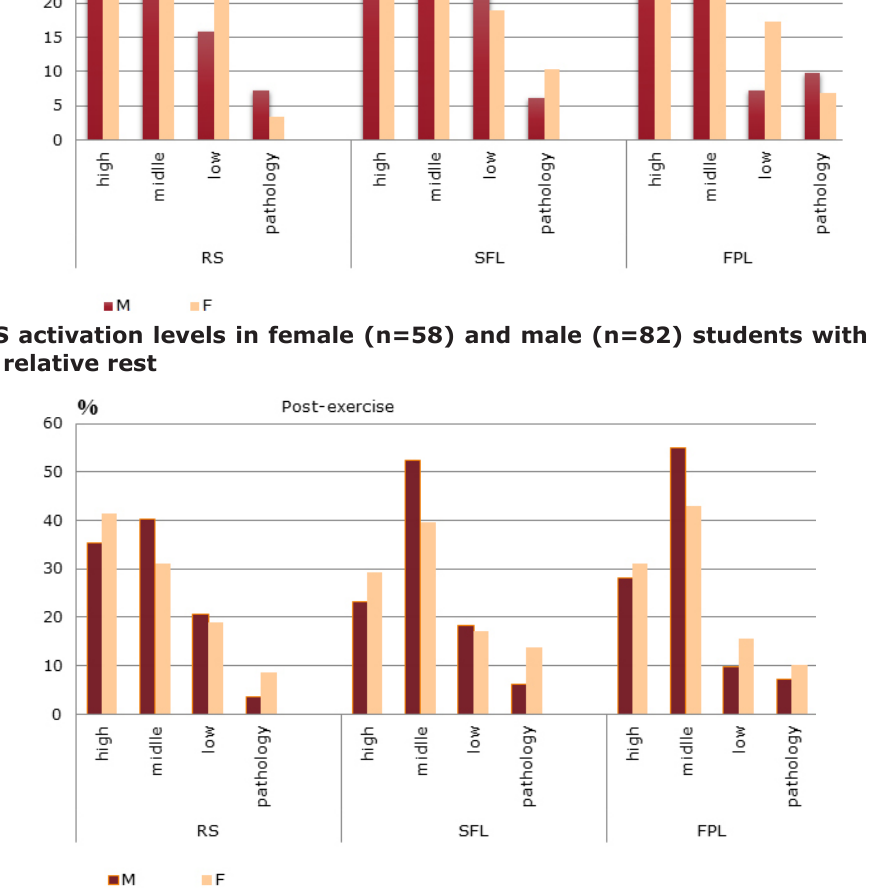
Fig. 2. Levels of CNS activation in female (n=58) and male (n=82) students after dosed physi - cal activity in a closed